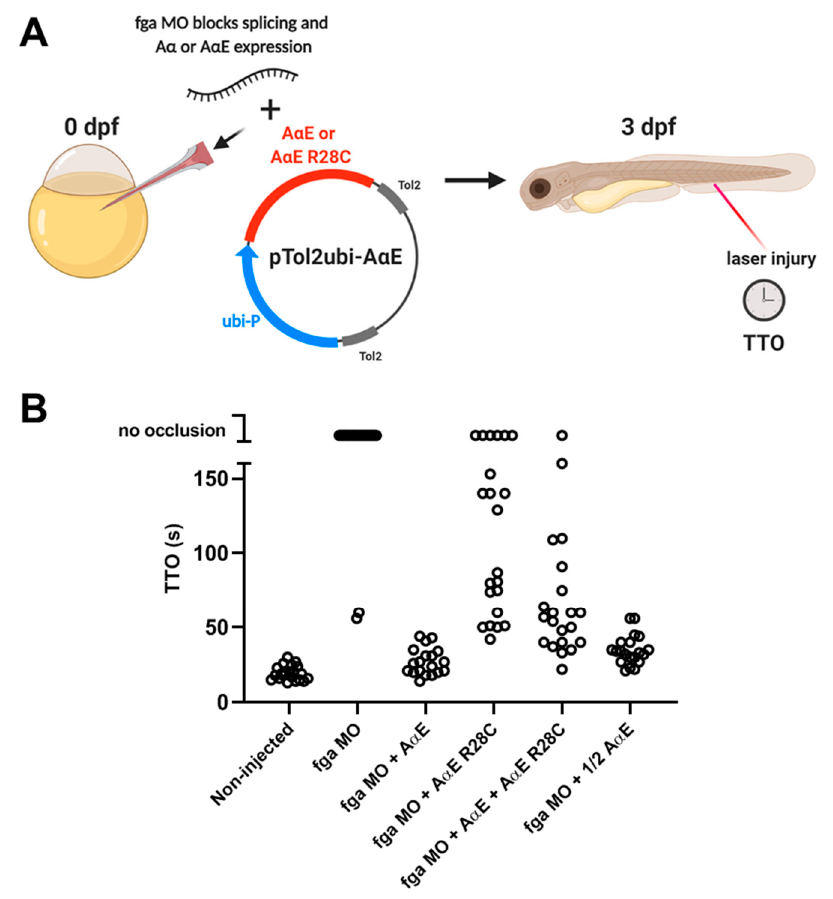
Figure 7. TTO measurements in fga morpholino knockdown embryos with transgenic expression of A α E, A α E R28C, or both, to model dysfibrinogenemia. ( A ) A scheme representing the experimental set-up. Early TU zebrafish embryos were injected with and without an fga mRNA-targeting morpholino (MO) in the absence or presence of Tol2 plasmids for ex- pression of fibrinogen A α E, A α E R28C, A α E + A α E R28C or a half quantity of A α E (1/2 A α E). Tol2 transposase mRNA was also present within injection mixes (not shown). At 3 dpf the TTO assay was performed to measure venous thrombosis time. The MO inhibits endogenous fga mRNA splicing but cannot target the transgenically expressed A α E and A α E R28C mRNAs. ( B ) TTO data for each experimental group, each circle represents one larva ( n = 19 to